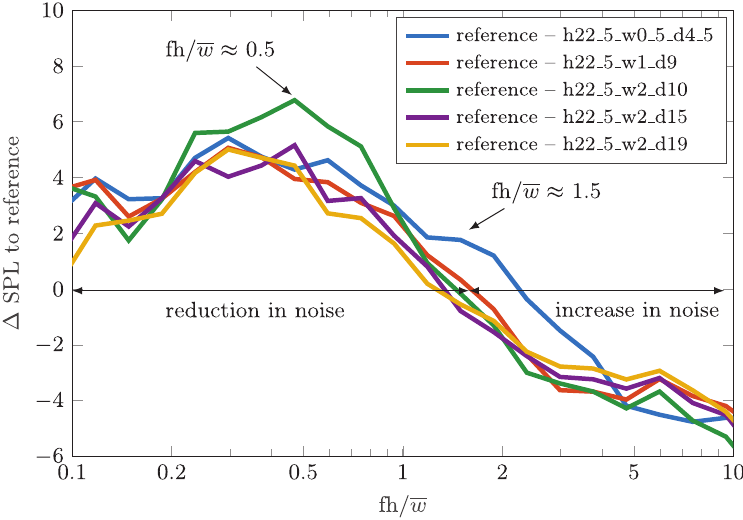
Figure 7. Difference one-third octave band spectra from the slitted axial fans to the reference fan as a function of the dimensionless